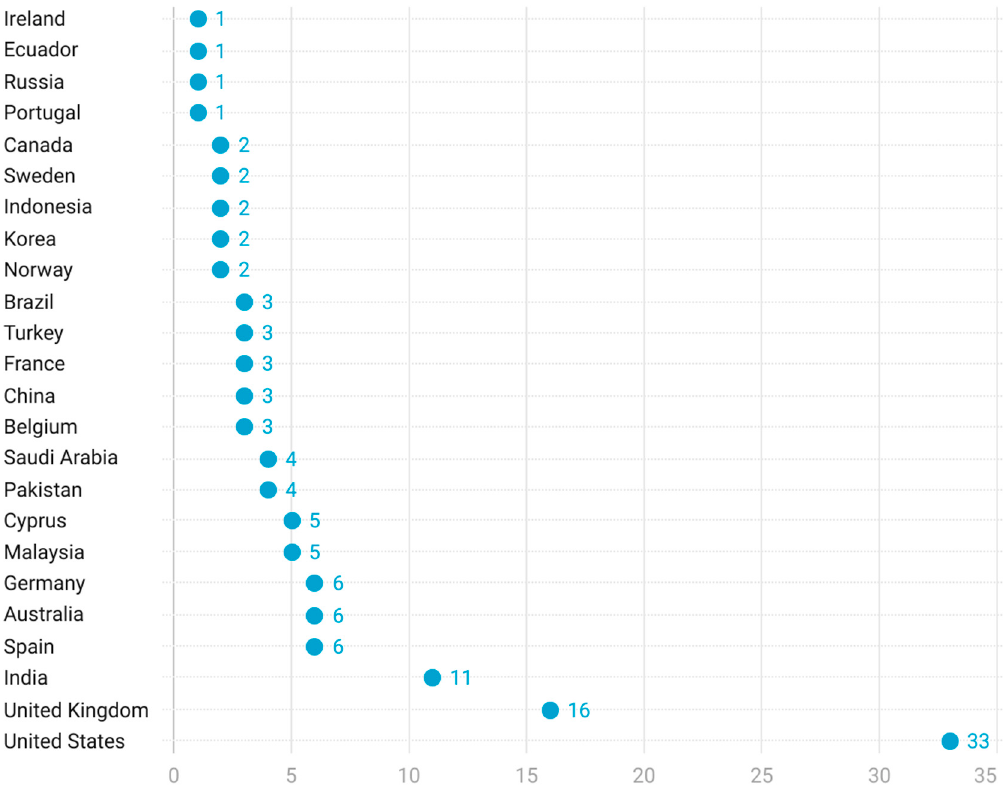
Figure 3. Research articles per country.